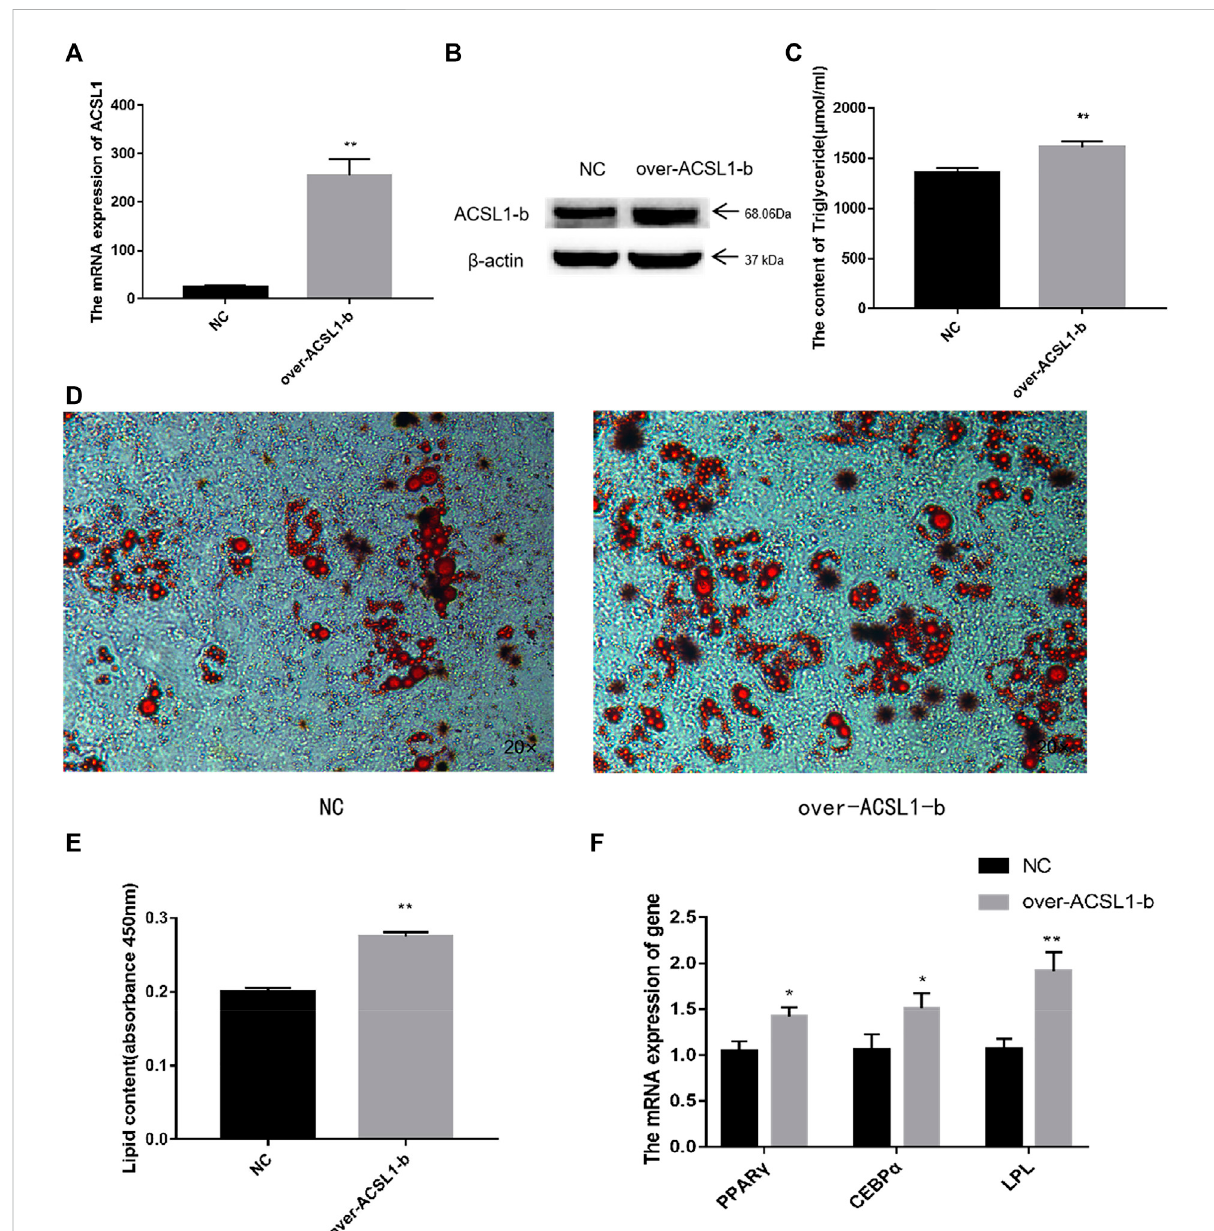
FIGURE 4 Overexpression of the ACSL1-b in sheep preadipocytes: (A) mRNA expression of the ACSL1-b on day 8 of differentiation (* p < 0.05, ** p < 0.01). (B) Protein expressionoftheACSL1-b on day8ofdifferentiation. (C) Detection ofintracellulartriglyceridecontent. (D) OilRed staining ofadipocytes after induced differentiation on day 8 (left: control; right: overexpression ACSL1-b). (E) Absorbance value of Oil Red O after extraction. (F) mRNA expression of PPAR γ , CEBP α , and LPL in sheep adipocytes. NC: adipocytes transfected with the pBI-CMV3 vector for control. Over-ACSL1: adipocytes transfected with the pBI-CMV3 vector with ACSL1-b